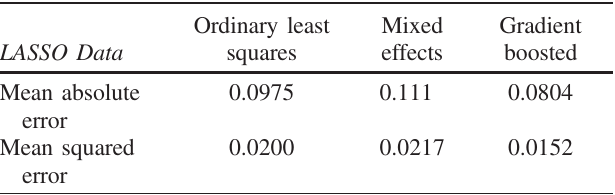
TABLE III. Out-of-sample model fit statistics for ordinary least squares, mixed effects, and gradient boosted models for the LASSO data study. In all cases, the gradient boosted models have “ better ” fit statistics in comparison to the linear models. This better fit is unlikely due to the boosted model over fitting the data. This better fit is evidenced by the linear models producing significantly different post score distributions using the out-of- sample data (see Fig.